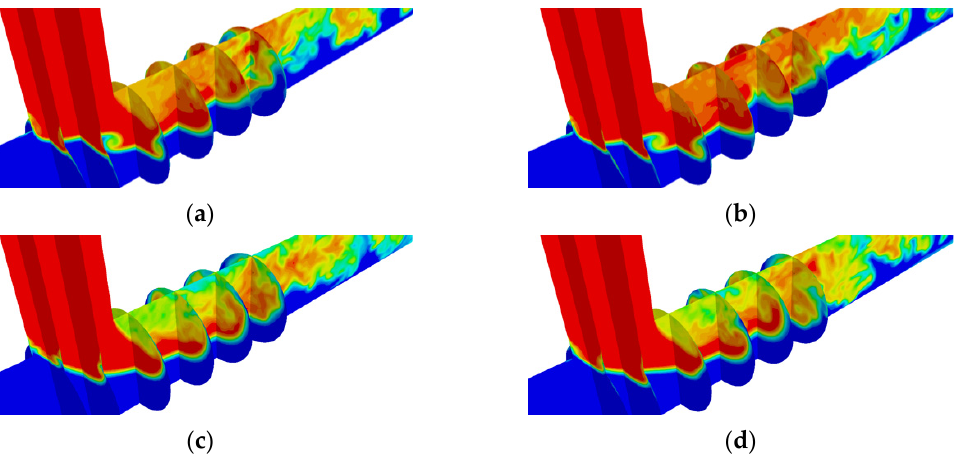
Figure 20. Contour plots of transient temperature for cases ‘0-0’ ( a ), ‘60-0’ ( b ), ‘0-60’ ( c ), and ‘60-60’ ( d ). The full videos are available via the link: https://doi.org/10.5281/zenodo.7299325.